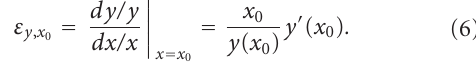
Figure 11: The changes of FCOE with